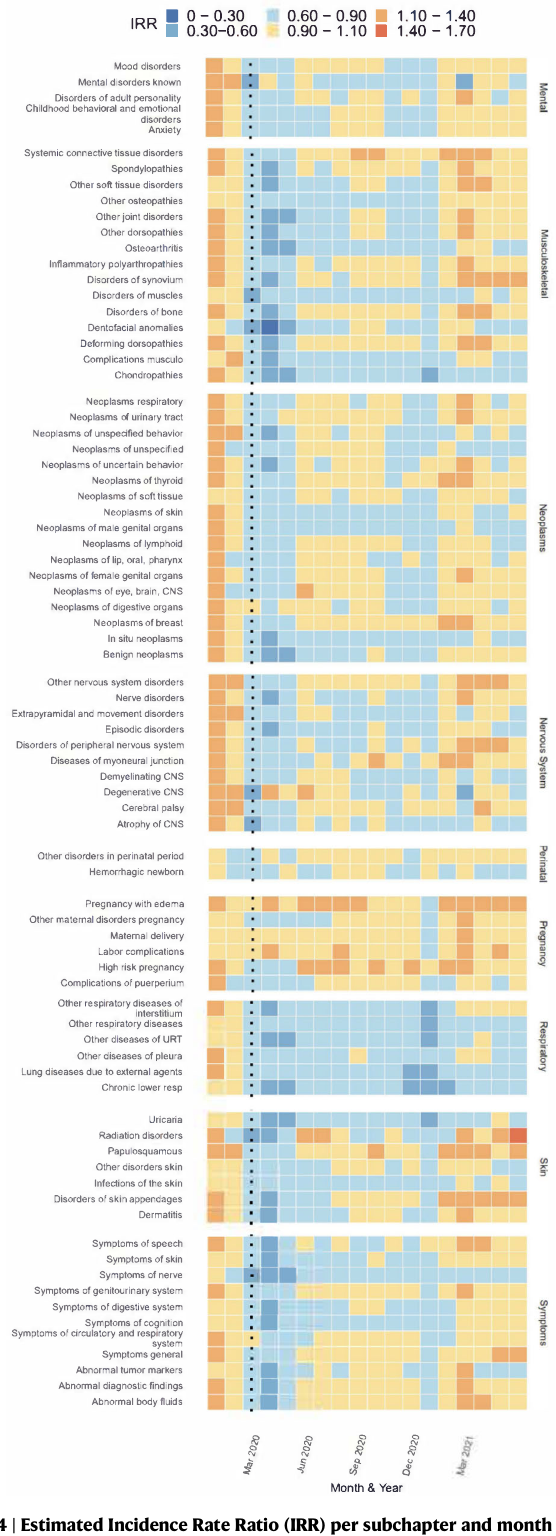
Fig. 3 | Estimated Incidence Rate Ratio (IRR) per subchapter and month from cluster C grouped according to diagnostic chapters (Blood, Congenital, Digestive, Ear, Endocrine, Eye, Genitourinary, and Infectious-Parasitic), Jan 2020 to Jun 2021. Note: Estimates of IRR made by dividing observed by predicted casesperdiagnosispermonth.Monthlypredictionsmadeusingtrendsinprevious years data after adjusting for seasonality and time trends with an offset for esti- mated active population.